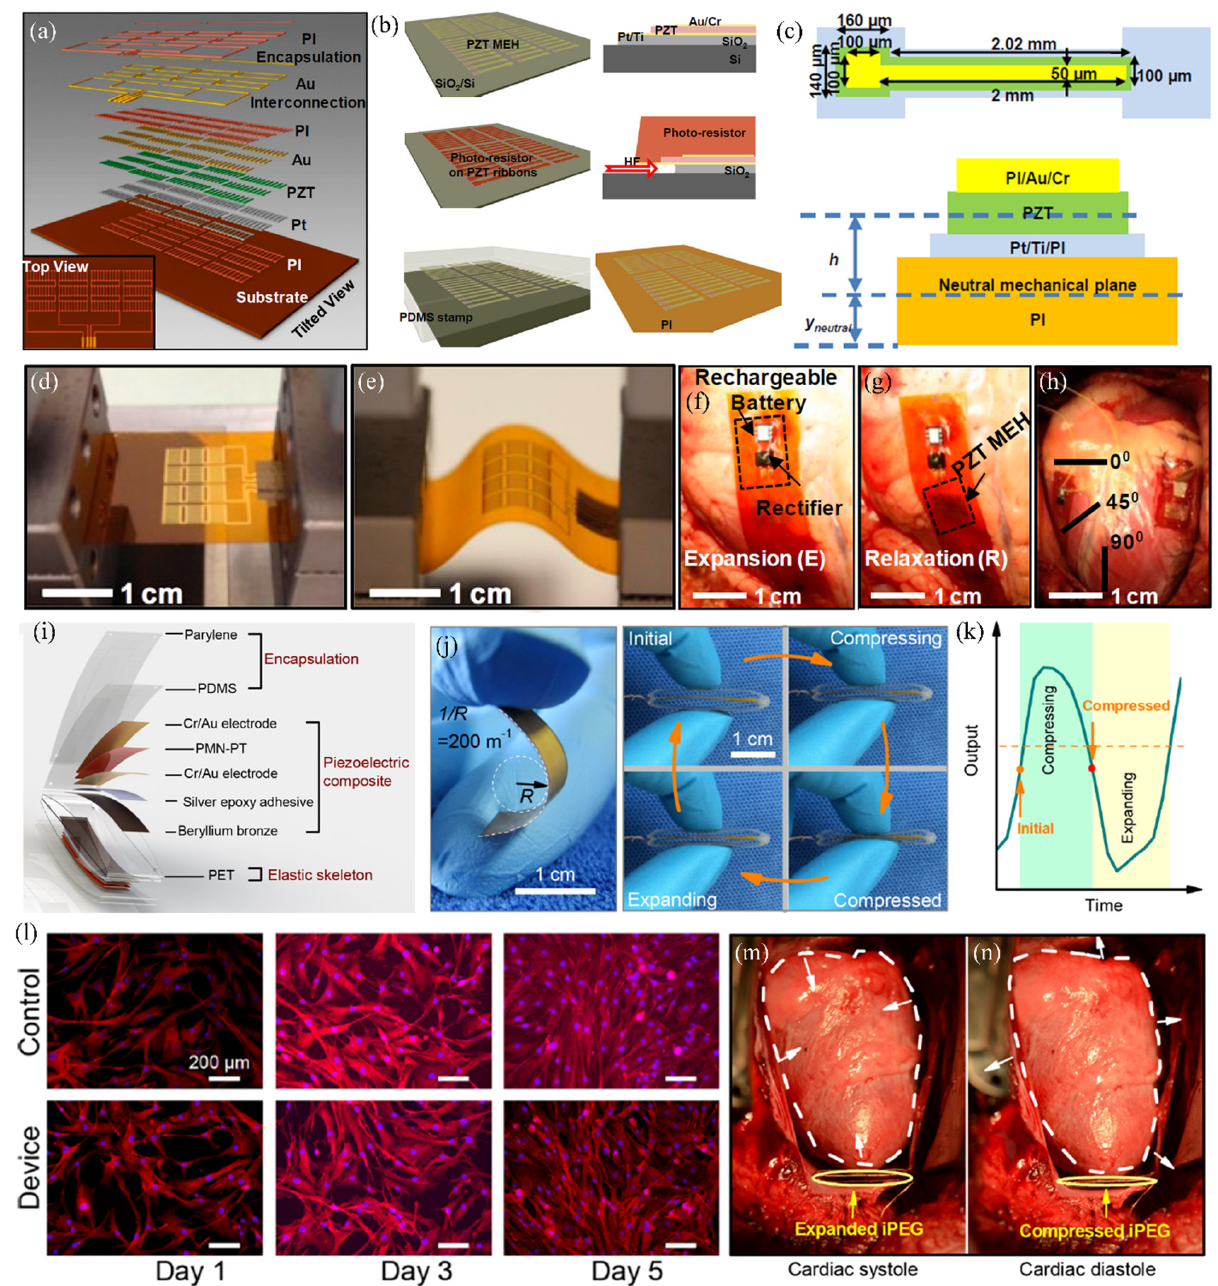
Figure 5. Piezoelectric thin transfer for the self-powered implantable electronics. ( a ) Exploded view and top view of the flexible MEH based on thin ribbons of PZT [145]. ( b ) Schematic illustration of procedures for fabricating a PZT MEH on a polyimide (PI) substrate [145]. ( c ) Top and cross-section view of a single PZT ribbon capacitor structure [145]. ( d ) and ( e ) Optical recordings of a PZT MEH clamped on a bending stage in flat and bent configurations [145]. ( f ) and ( g ) Images of PZT MEHs on the RV, LV, and free wall of a bovine heart [145]. ( h ) PZT MEH cointegrated with a rectifier and rechargeable battery [145]. ( i ) Exploded view of the detailed composited structures for the implantable piezoelectric generator [147]. ( j ) and ( k ) Piezoelectric composite bending by human fingers and corresponding output signals [147]. ( l ) Biocompatibility tests of the implantable piezoelectric generator using human pericardial fibroblasts [147]. ( m ) and ( n ) Optical images for the real-time monitoring of heart test using the proposed implantable device [147]. Reprinted with permission from ref. [145]. Copyright 2014 United States National Academy of Sciences. Reprinted with permission from ref. [147]. Copyright 2019 American Chemical Society.